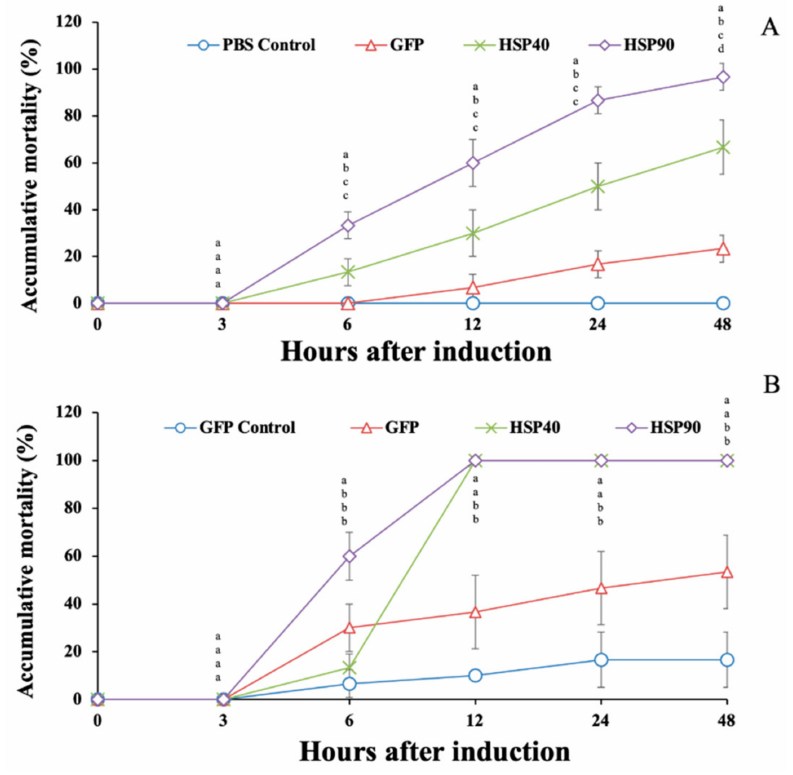
Figure 14. Effect of hsp40 and ds Mr-hsp90 gene knockdown on high-temperature (35 ◦ C) ( A ) and A. hydrophila infection conditions ( B ). Data with different letters (a, b and c) were significantly different ( p < 0.05) at the same time